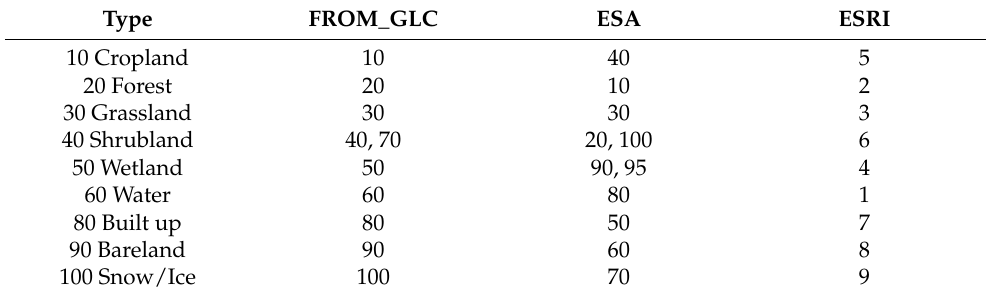
Table 3. Merged classification system and its correspondence with the original classification